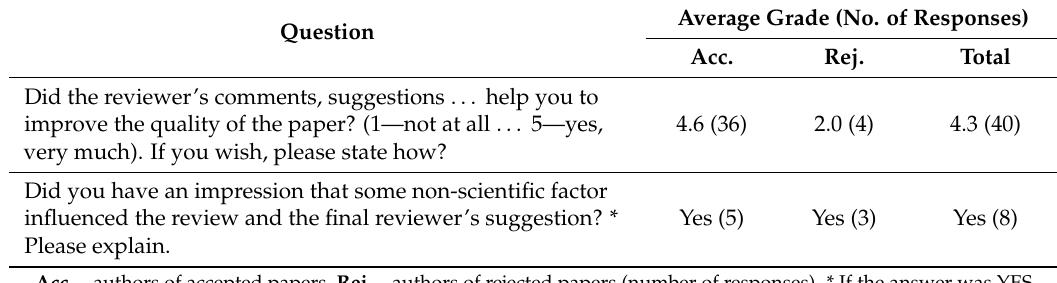
Table 7. Average grades which authors gave as a response to open questions.